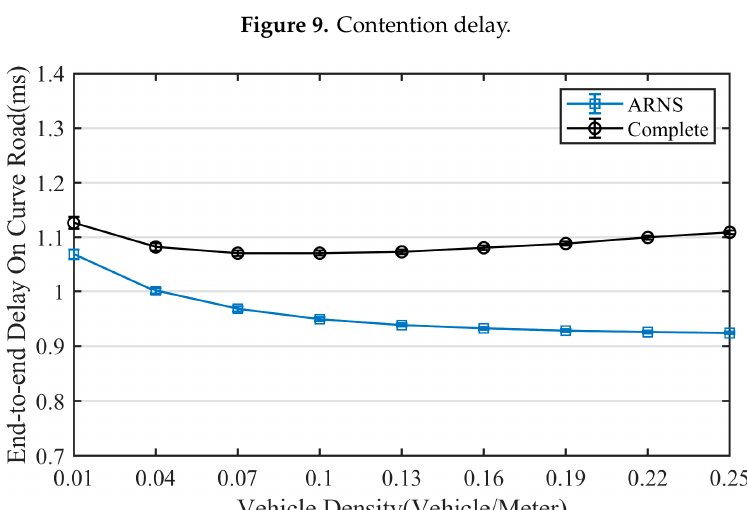
Figure 9. Contention delay.